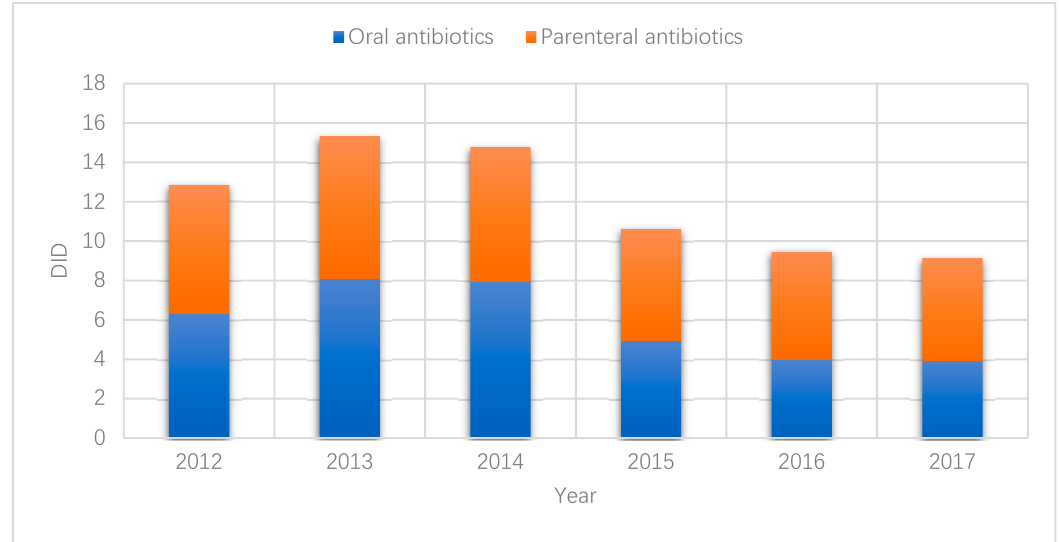
Figure 2. Sales of oral and parenteral antibiotics in primary care settings in Hubei, China, 2012–2017.